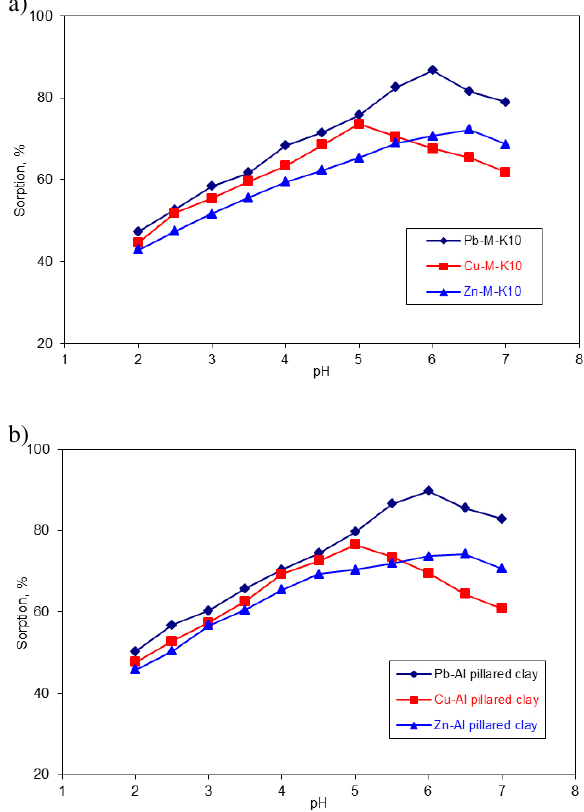
Fig. 4. Dependence of adsorption process on pH value: montmoril- lonite- K10 (a), Al-pillared clay